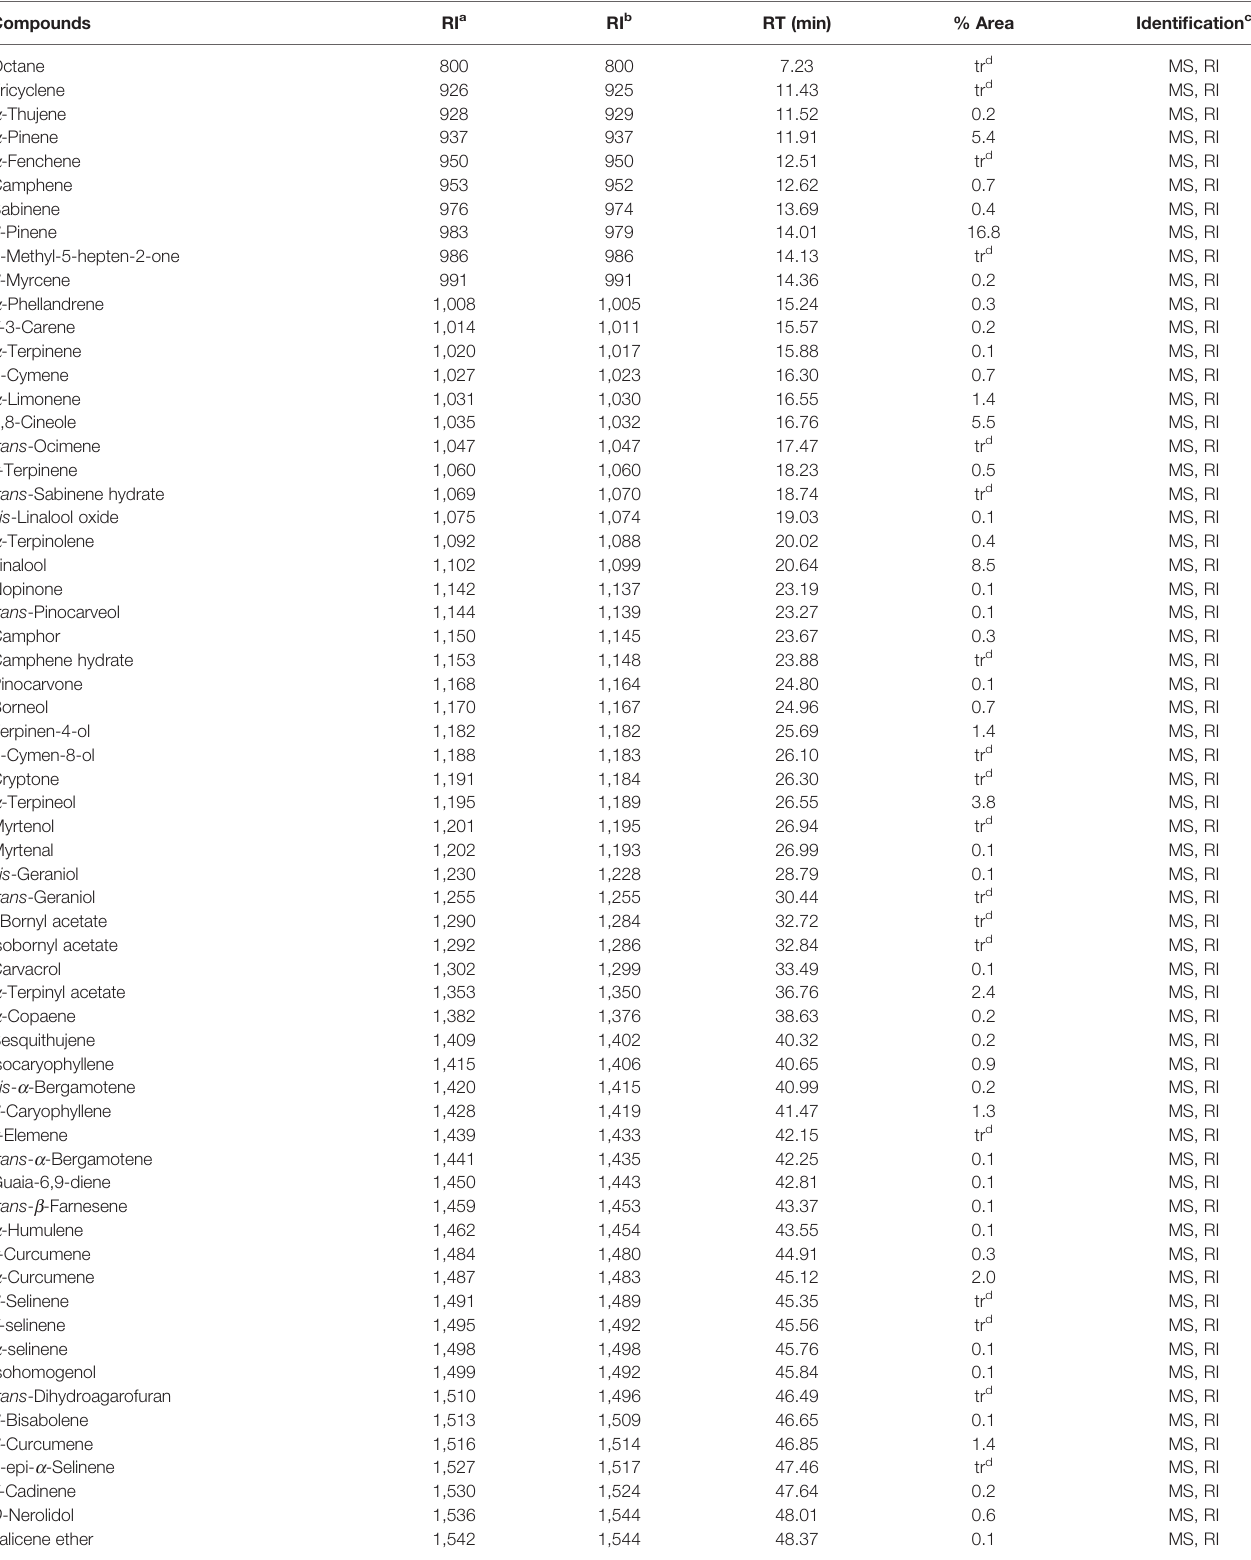
TABLE 1 | Chemical components of the essential oil from H. fl avum rhizome. Compounds RI a RI b RT (min) % Area Identi fi cation c